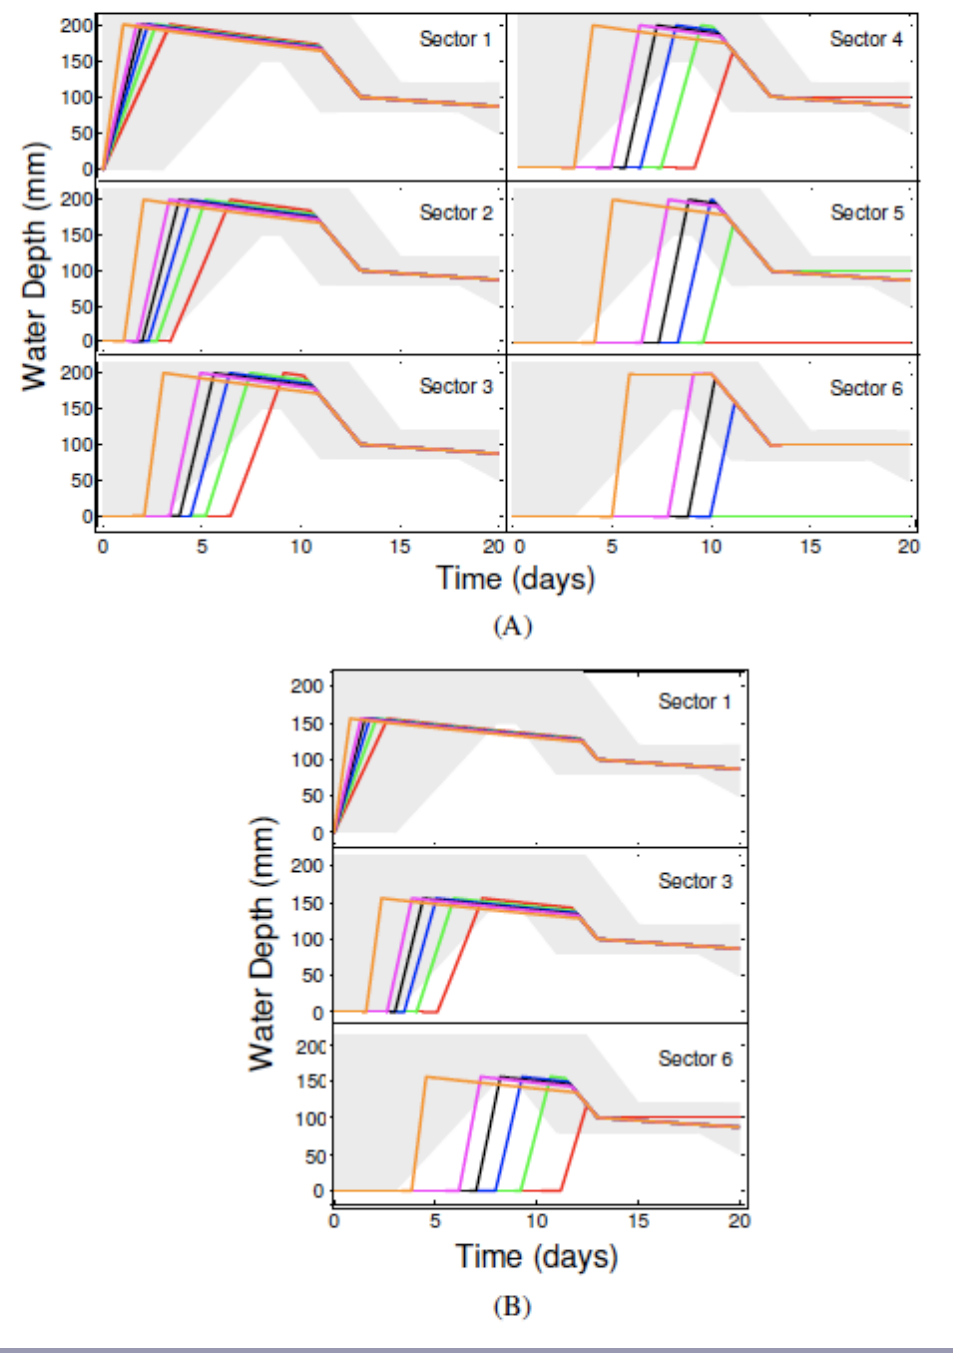
Fig. 7 . Irrigation water supply profiles (color coded to match discharge scenarios in Figure 6) superimposed on desired supply level range (gray shaded area). (A) and (B) show the water distribution under the sequential and optimized sequential regimes,